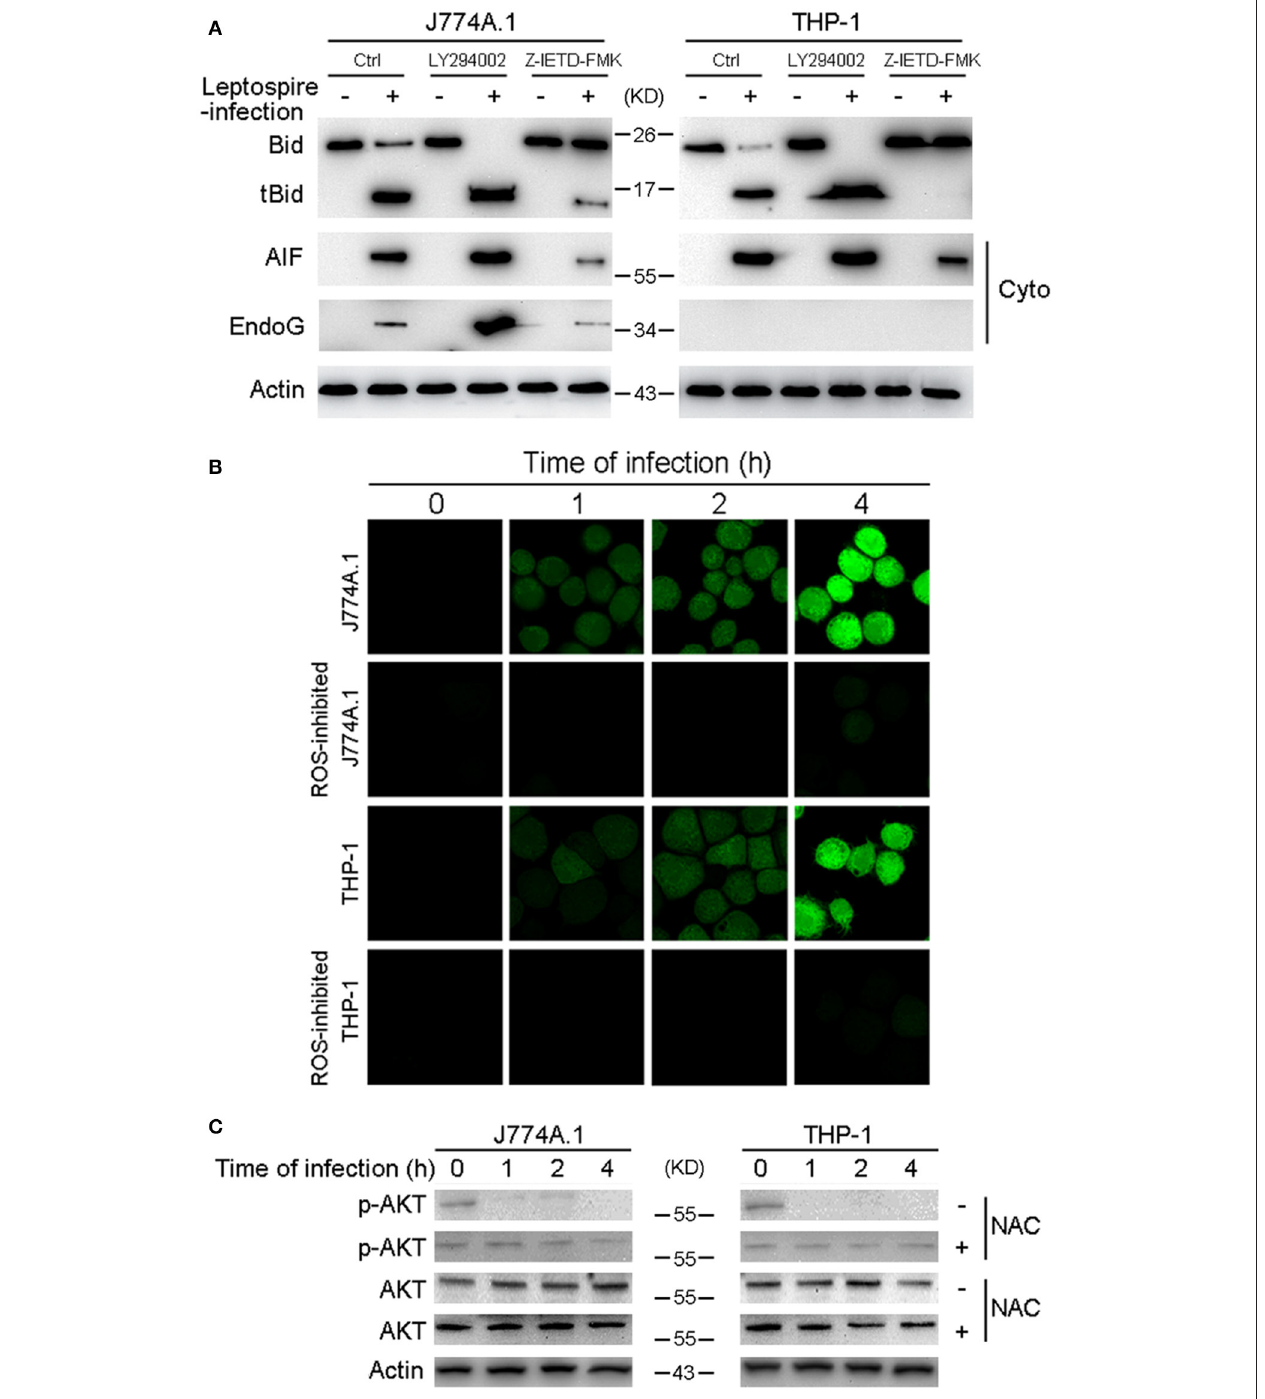
FIGURE 5 | Caspase-8 activation and ROS induced Akt inactivation mediates the activation of Bid and the release of AIF, EndoG. (A) The activation of Bid and the release of AIF and EndoG in Caspase-8 or Akt inhibited macrophages during infection. The macrophages pretreated with caspase-8 inhibitor Z-IETD-FMK or PI3K/Akt pathway inhibitor LY294002 were infected with leptospires for 4h. (B) ROS level in macrophages infected with L. interrogans strain Lai for the indicated times. The cells were stained with DCFH-DA, an ROS-specific fluorescent dye, which become green due to an increase in ROS levels. NAC was used to neutralize intracellular ROS. (C) The dephosphorylation of Akt in macrophages infected with L. interrogans strain Lai for the indicated times. NAC was used to neutralize intracellular ROS. Representative results of three experiments with consistent results are shown.